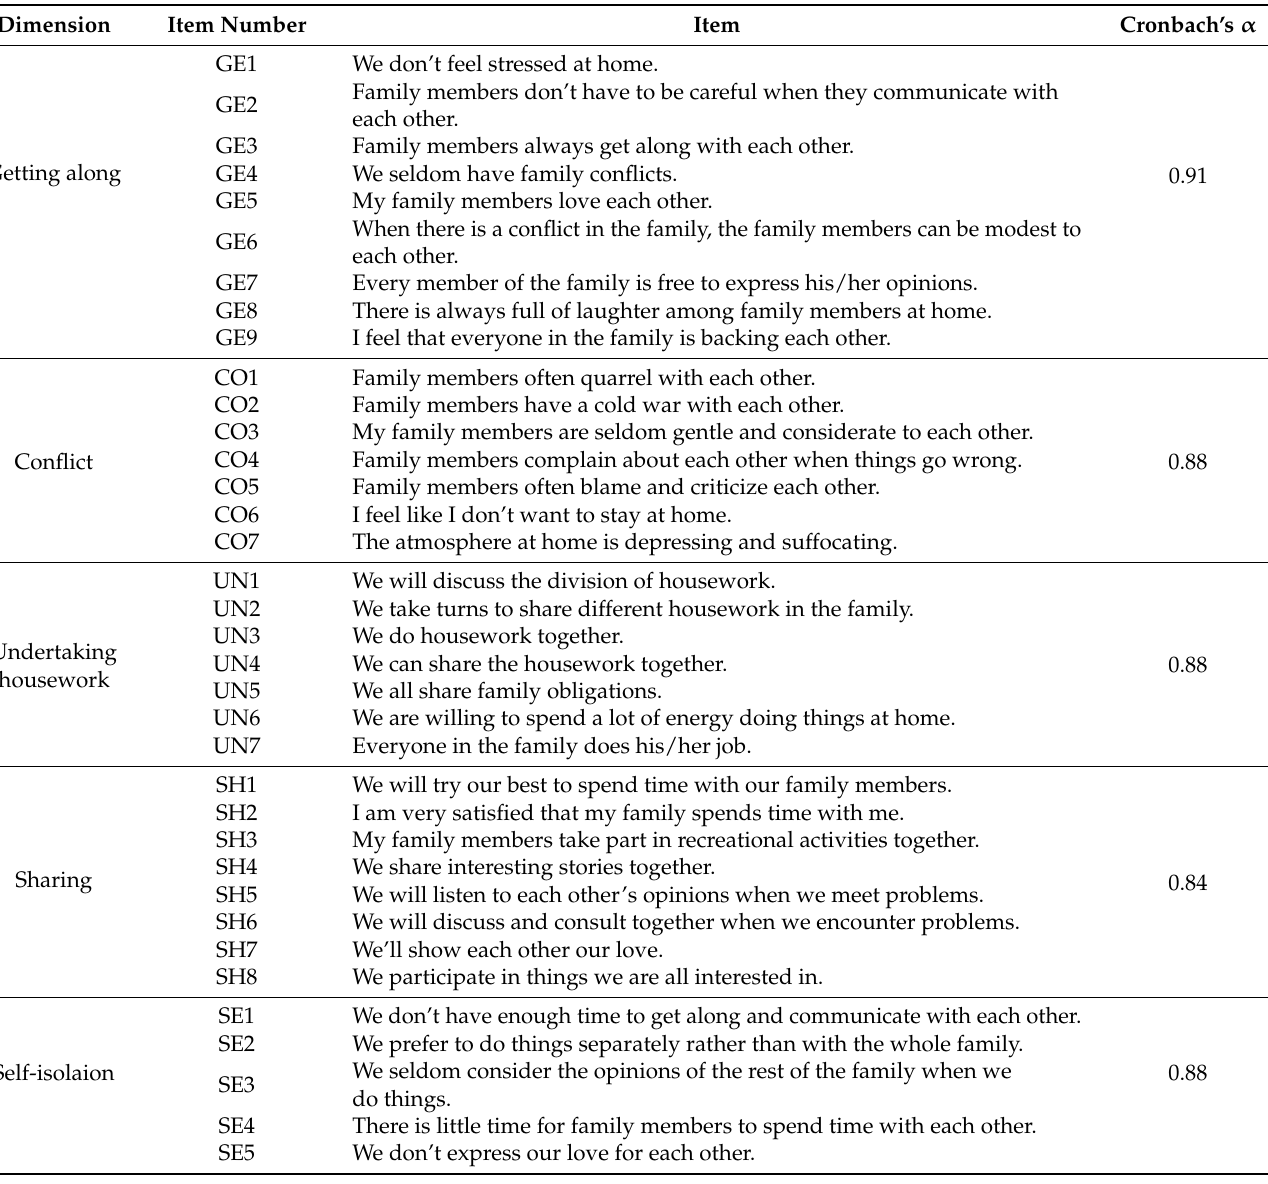
Table 1. The college students’ experience of family harmony questionnaire